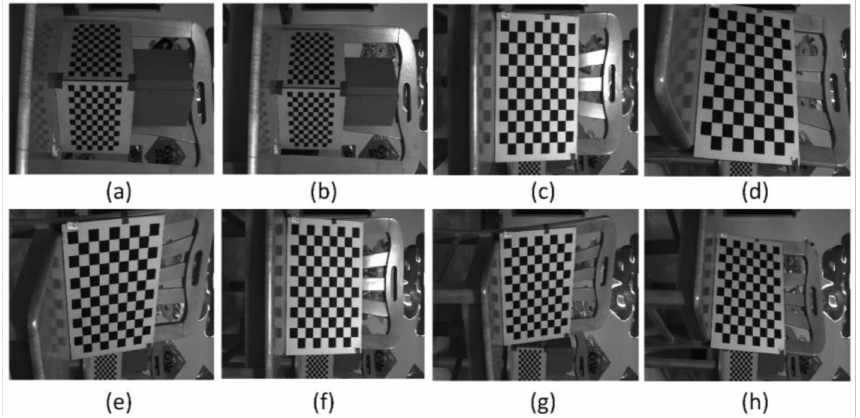
Figure 14. Images for 3D construction when the anamorphic lens was in the horizontal position.